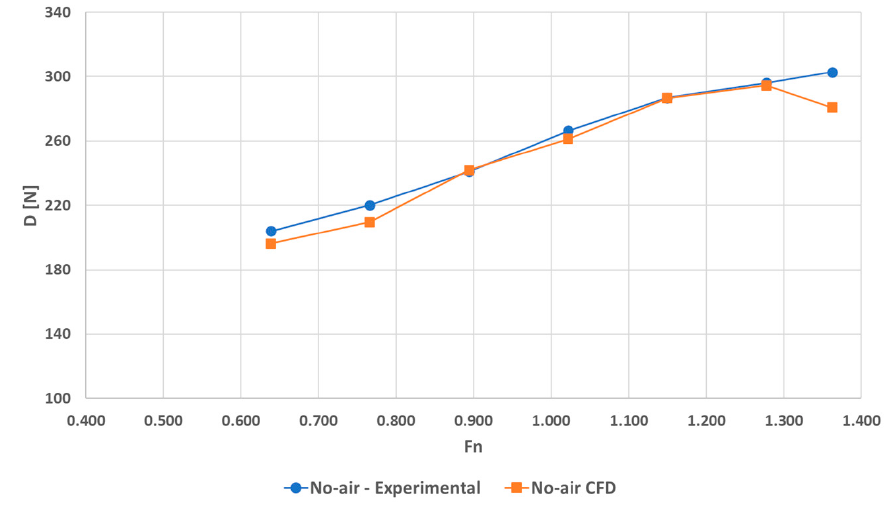
Figure 10. Resistance curves comparison.